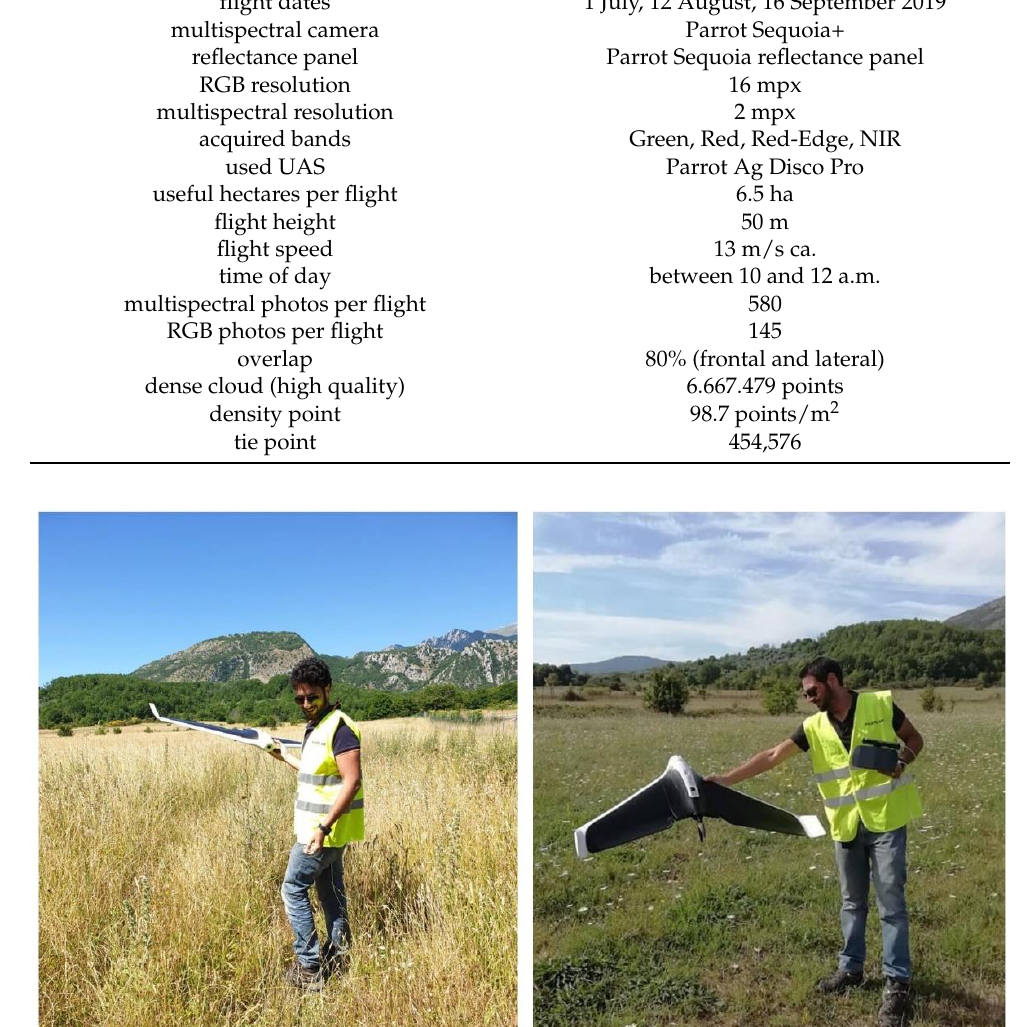
Table 1. Summary of the flight and processing parameters.